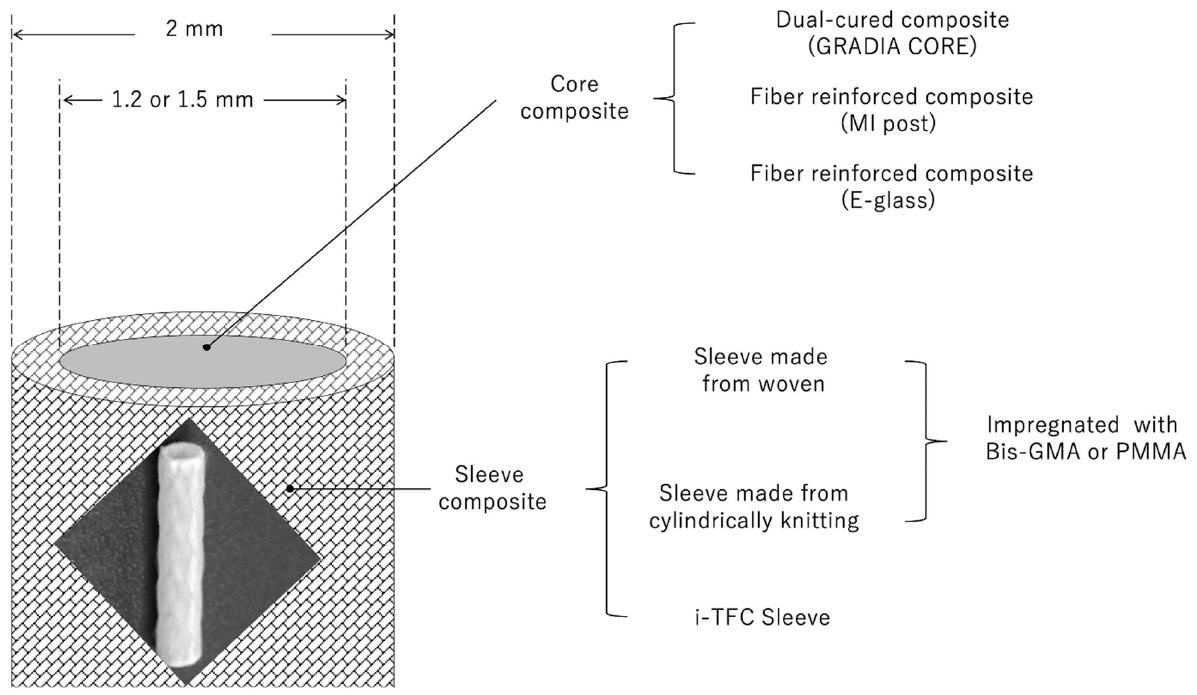
Figure 1. Schematic drawing of hollow sleeve composite.